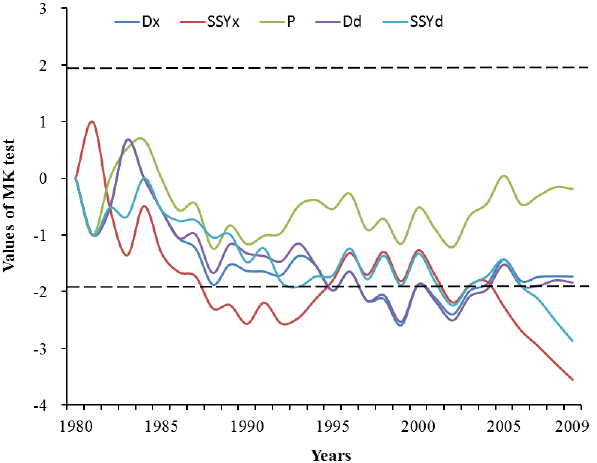
Figure 5. Results of the Mann–Kendall test.